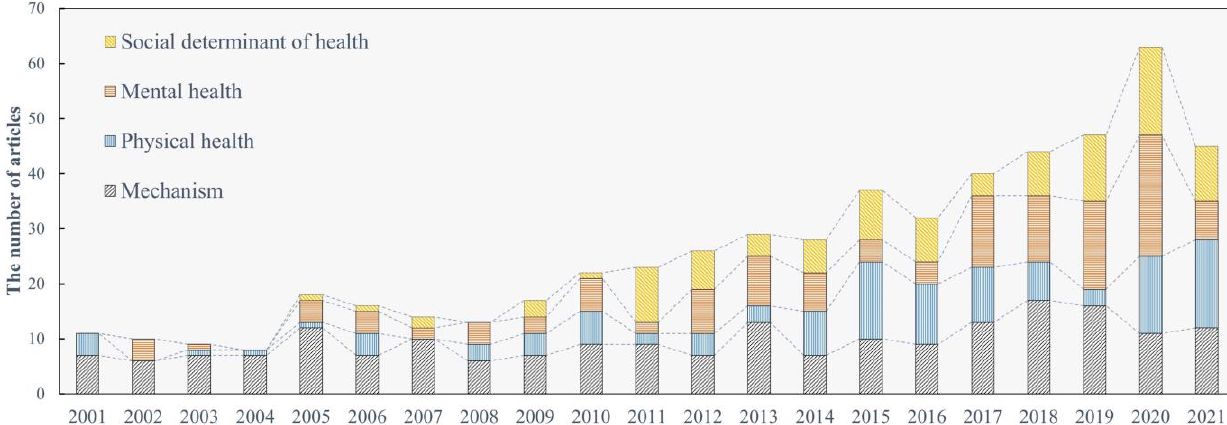
Figure 2. The temporal evolution of research on ALAN’s effects on human health.